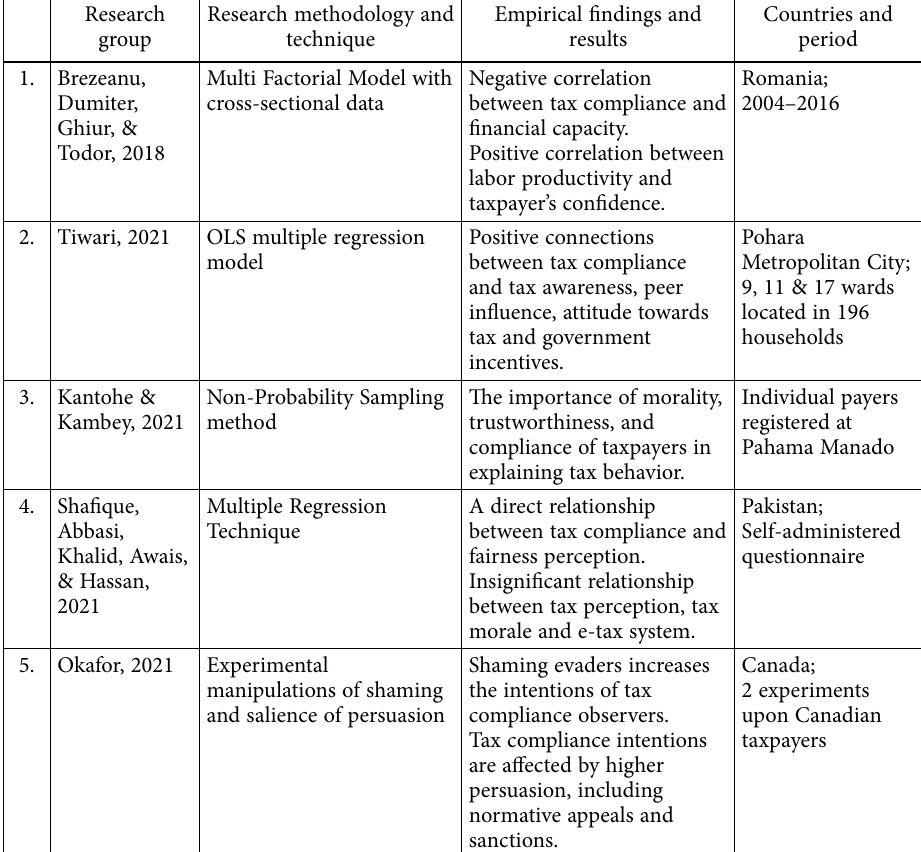
Table 2. Previous empirical studies regarding tax compliance (source: own